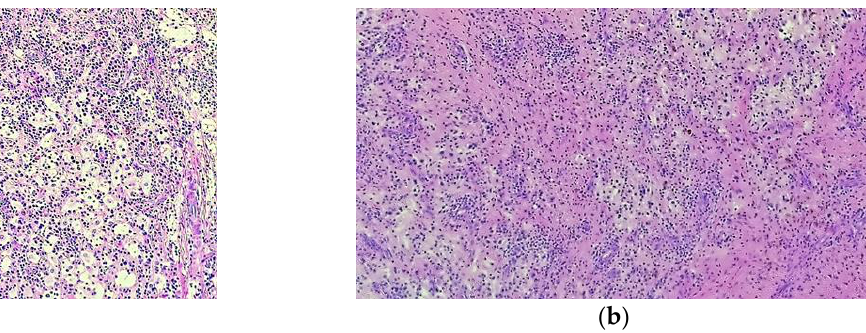
Figure 7. Prominent population of histiocytes characterized by large, round nuclei and voluminous cytoplasm showing emperipolesis with engulfment of lymphocytes ( a ) HE staining; 40×; ( b ) HE staining 400×.